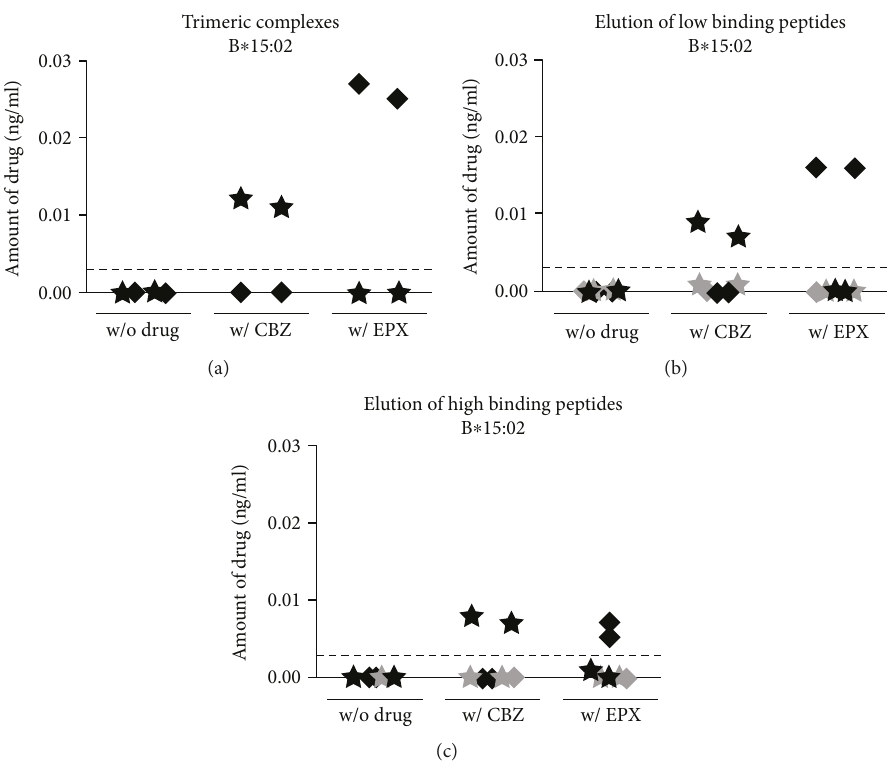
Figure 2: CBZ and EPX bind to the HLA heavy chain and not to the peptides. sB ∗ 15:02 molecules were produced in the HLA class I-negative LCL721.221 cell line without treatment and in the presence of CBZ or EPX and puri fi ed via a ffi nity chromatography. The amount of the drugs was measured mass spectrometrically (CBZ shown as ★ , EPX shown as ◆ ). The threshold for drug detections is represented by a dashed line. The trimeric complexes (a) were analyzed as well as retentate and peptide fractions after separation of low (b) and high binding peptides (c). The amount of drug measured in the HLA heavy-chain fraction is displayed in black; the amount measured in the peptide fraction is shown in